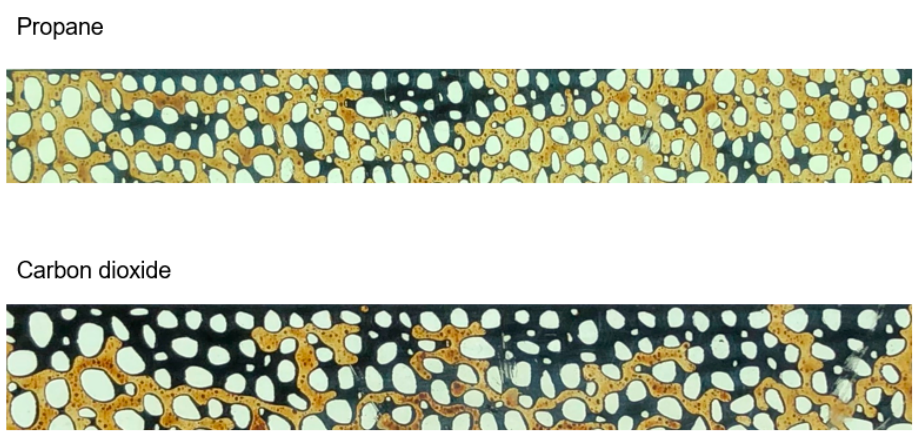
Figure 22. The solvent–heavy oil interactions near the reservoir top boundaries.